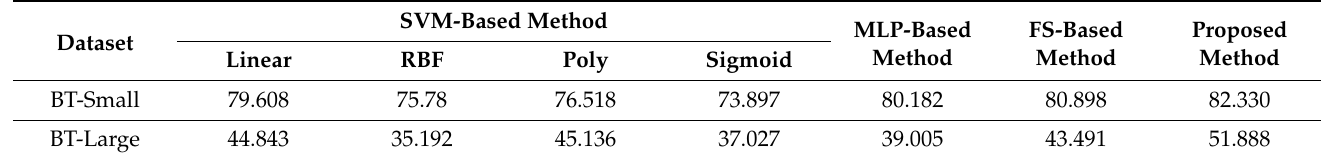
Table 12. Evaluation of the classification performance (F1Score) of our proposed method in compari- son to the SVM-, MLP-, and FS-based methods (unit: %).